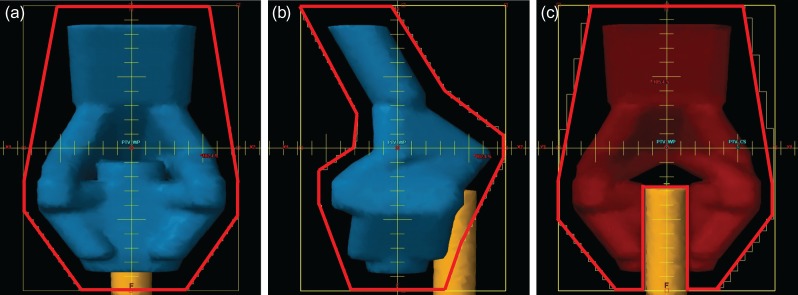
Irradiation fields of the phantom study (shown by red lines): (a) anterior–posterior field of whole-pelvis irradiation; (b) left–right field of whole-pelvis irradiation; and (c) anterior–posterior field of pelvis irradiation with central shielding. The width of the midline block in (c) was set as 3 cm. The PTV-WPphantom, PTV-CSphantom, and rectumphantom are shown in the figure.